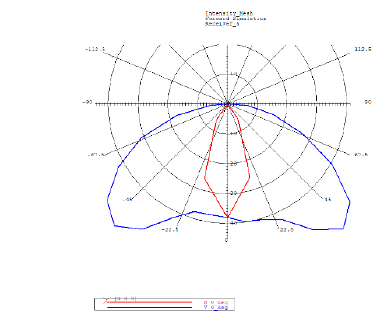
Figure 8. The recorded value curve of merit function in the optimization process.